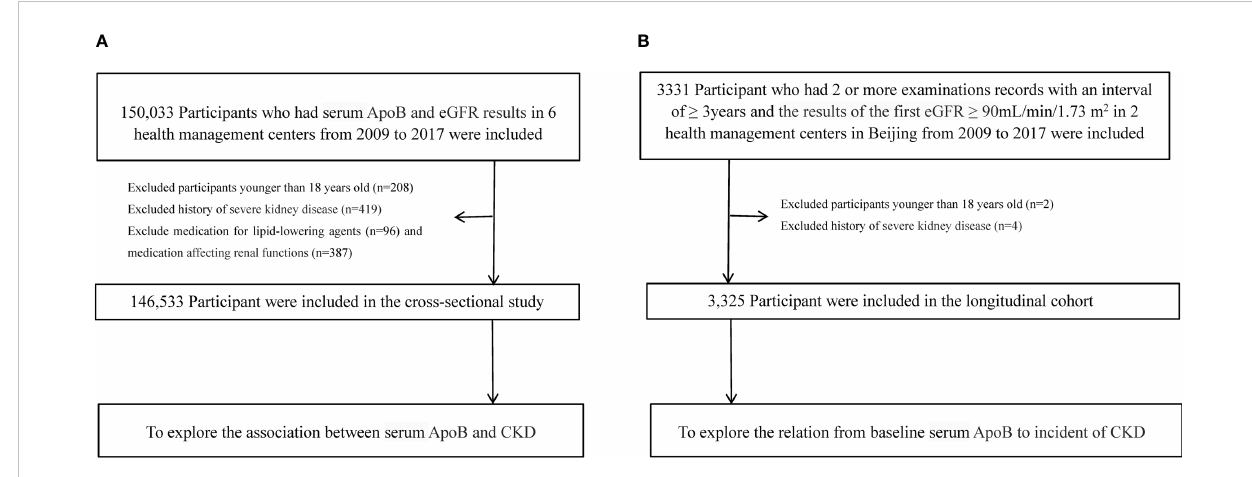
FIGURE 1 Flow chart of participants. (A) Flow chart of participants in the cross-sectional analysis. (B) Flow chart of participants in the longitudinal